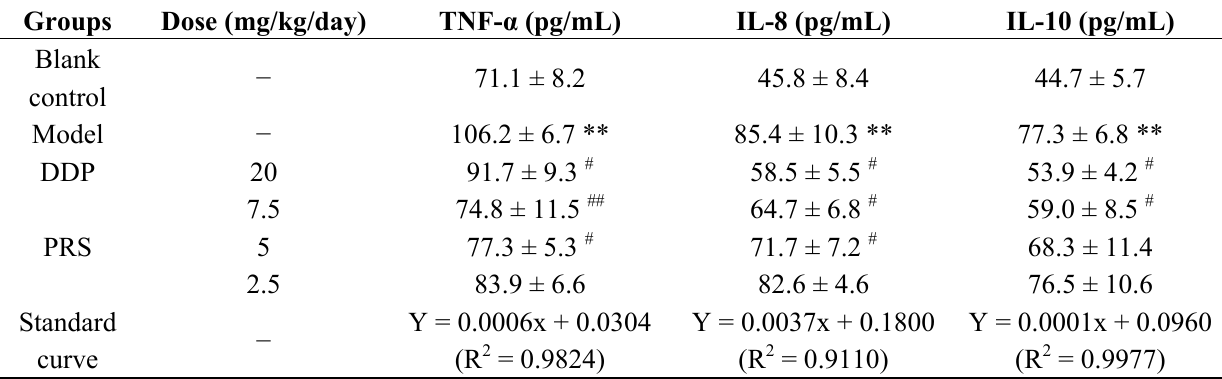
Table 2. Effect of PRS on the levels of inflammatory factors in Lewis tumor-bearing mice ( n = 6).